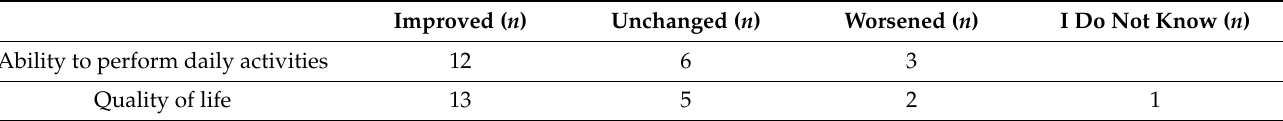
Figure 2. Patient-perceived efficacy of LECIG on PD symptoms ( n = 21). Most patients reported improvement in the ability to perform daily activities and in their self-rated quality of life (Table 7). Table 7. Patient-perceived ability to perform daily activities and quality of life after initiation of LECIG ( n = 21).